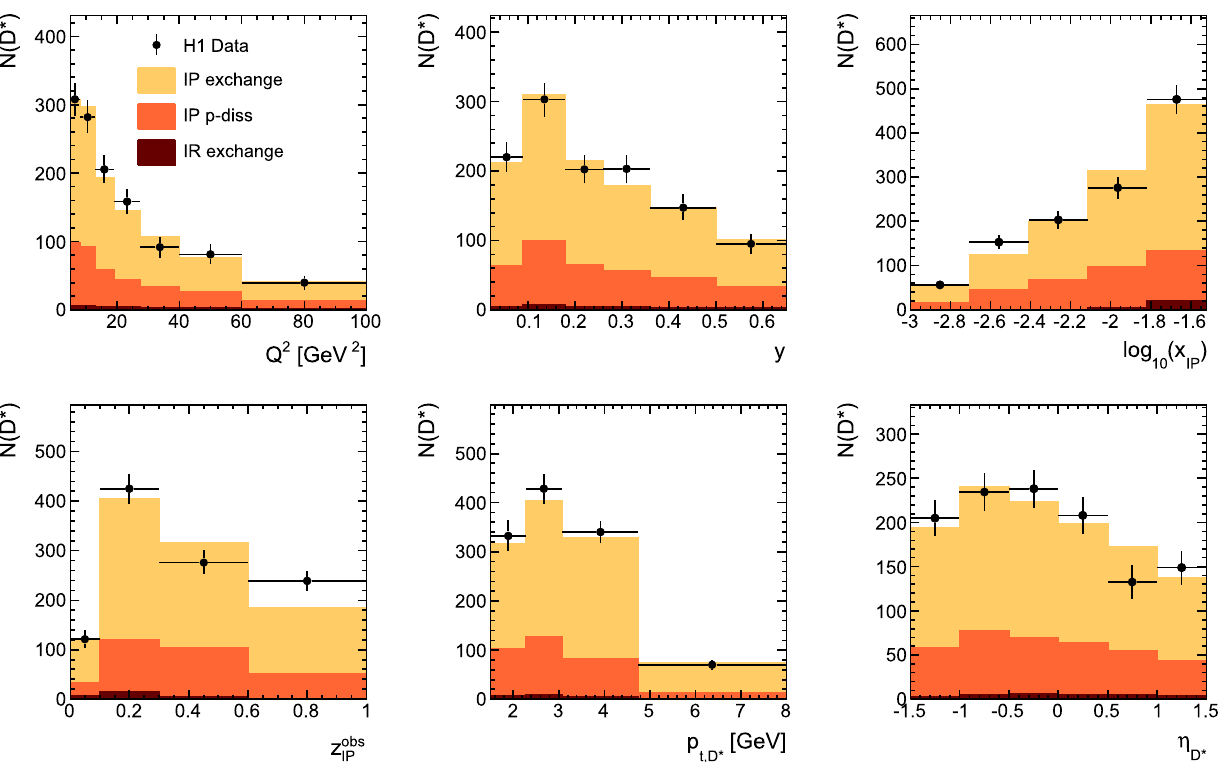
by filled histograms as follows; elastic proton pomeron exchange ( light orange ), proton dissociation ( dark orange ) and reggeon exchange ( dark , p t , D ∗ IP red )